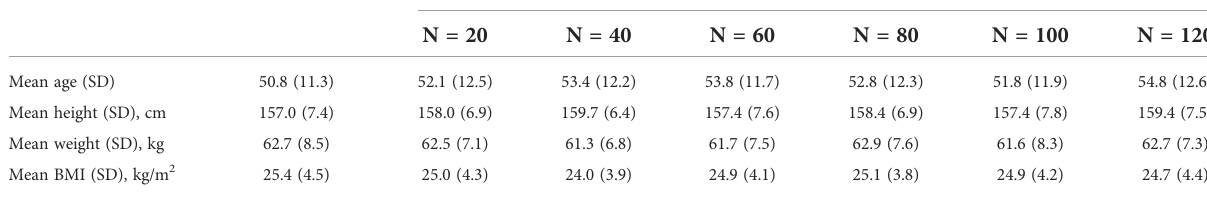
TABLE 1 Characteristics of atlas library and tested